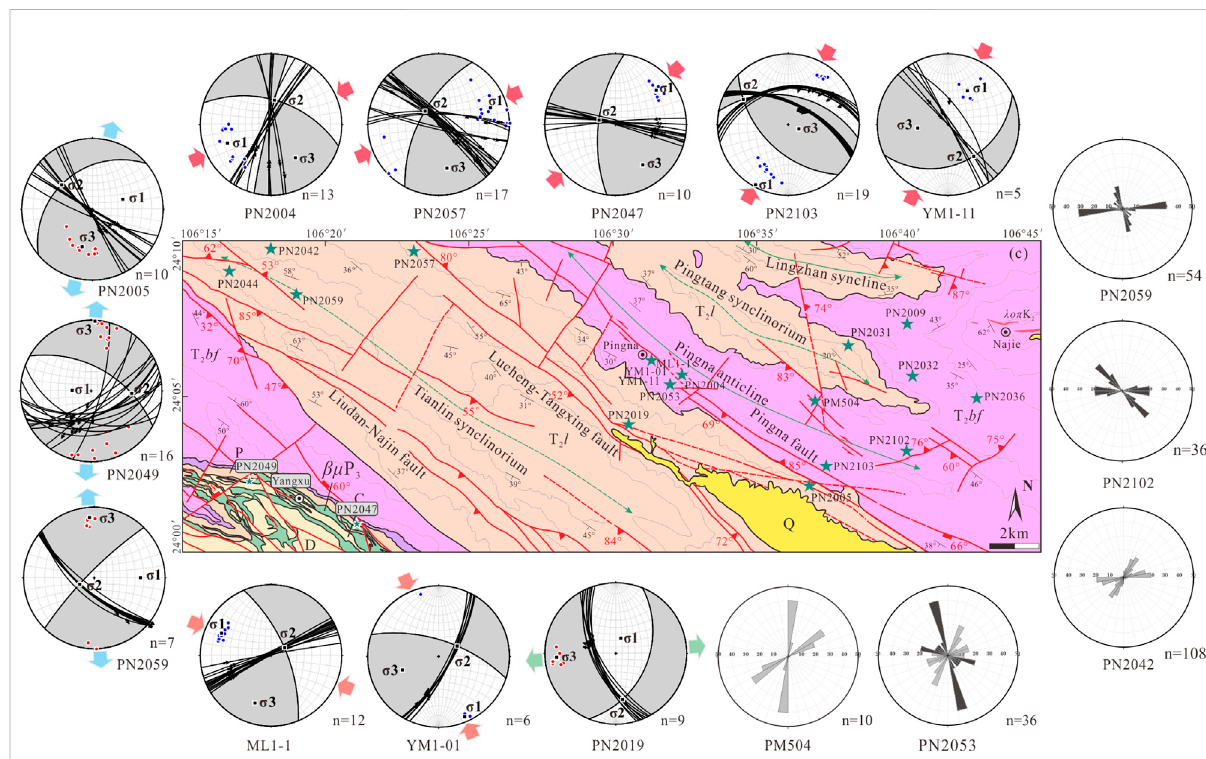
FIGURE 6 Stereographic plots of the main faults and conjugated joints in the study area. The observation points are shown with green pentagrams. The lower-hemisphere stereographic projection ofbrittlefaults documentsfour phases of deformation and the rosediagram of conjugate documentsa NE – SW and NW – SE compression regime.